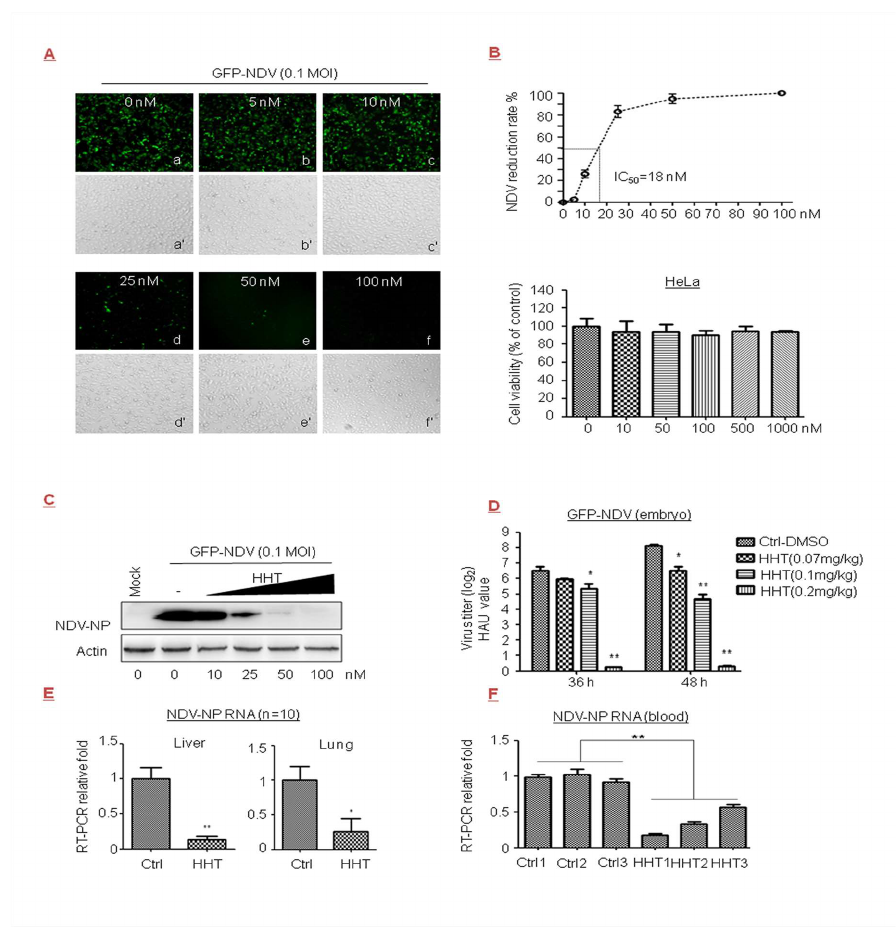
Figure 2. Inhibitory effect of HHT on Newcastle disease virus (NDV) infection in cells, embryos, and chickens. ( A – C ) Dose-dependent studies. HeLa cells seeded at 2.5 × 10 5 cells per well in 24-well plates were exposed to GFP-NDV at 0.1 MOI in the presence of HHT at increasing concentrations for 24 h. Expression of GFP was directly observed using a DP73 camera by fluorescence microscopy on an Olympus IX73 microscope 25 (magnification 10 × ) ( a – f ), and were assessed under light microscopy ( a (cid:48) – f (cid:48) ). One image is representative of three ( A ). Under the same experimental conditions, the infection rate of HHT on GFP-NDV infection was expressed as percent reduction in fluorescence activity of the infected cells without HHT treatment, which was set at 0%. Half maximal inhibitory concentration (IC 50 ) was calculated as indicated by the fine dotted lines. These experiments were performed two times with three replicates in each experiment. Values represent means and SD. Bottom, effects of HHT on HeLa cell viability were determined, and assessed as indicated in Figure